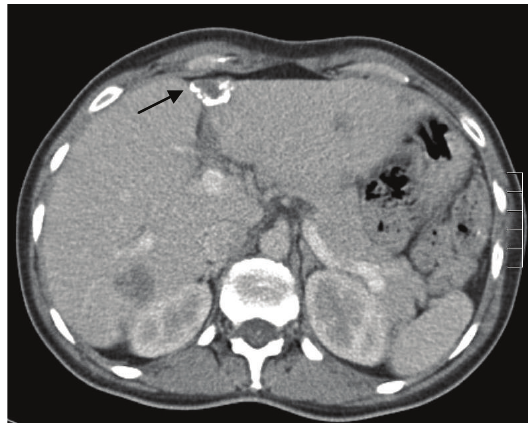
Figure 1: Abdominal CT scan, with intravenous contrast showing several hypodense lesions on both liver lobes. Arrow shows lesion with